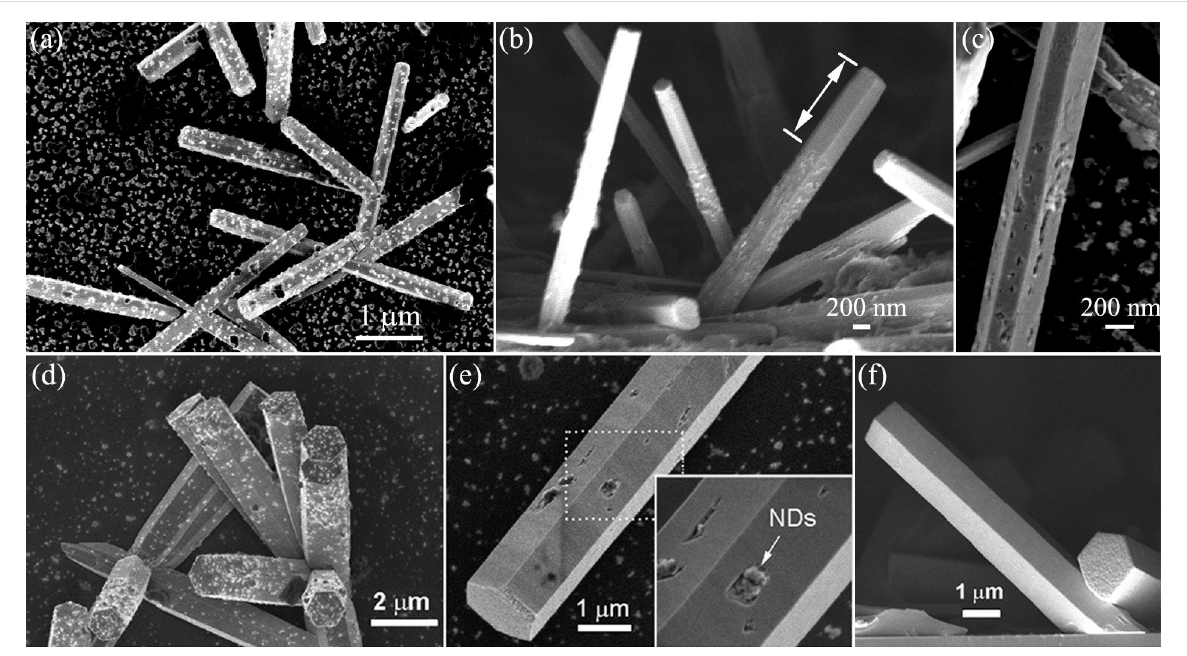
Figure 1: FE-SEM images showing the encapsulation of 10-nm-diameter NDs into ZnO nanorods and microrods. (a) Thin nanorods with NDs at- tached to their surfaces. (b) After a second growth process of ZnO nanorods. (c) A close-view of the nanorod, showing the embedment of NDs into the rod and the newly-grown section with smooth surface. (d) Relatively thick microrods with NDs in their surfaces. (e) After a second growth process, most of the NDs were encapsulated into the microrod, leaving some NDs clusters partially exposed. (f) NDs were completely encapsulated into the nanorod, given long regrowth